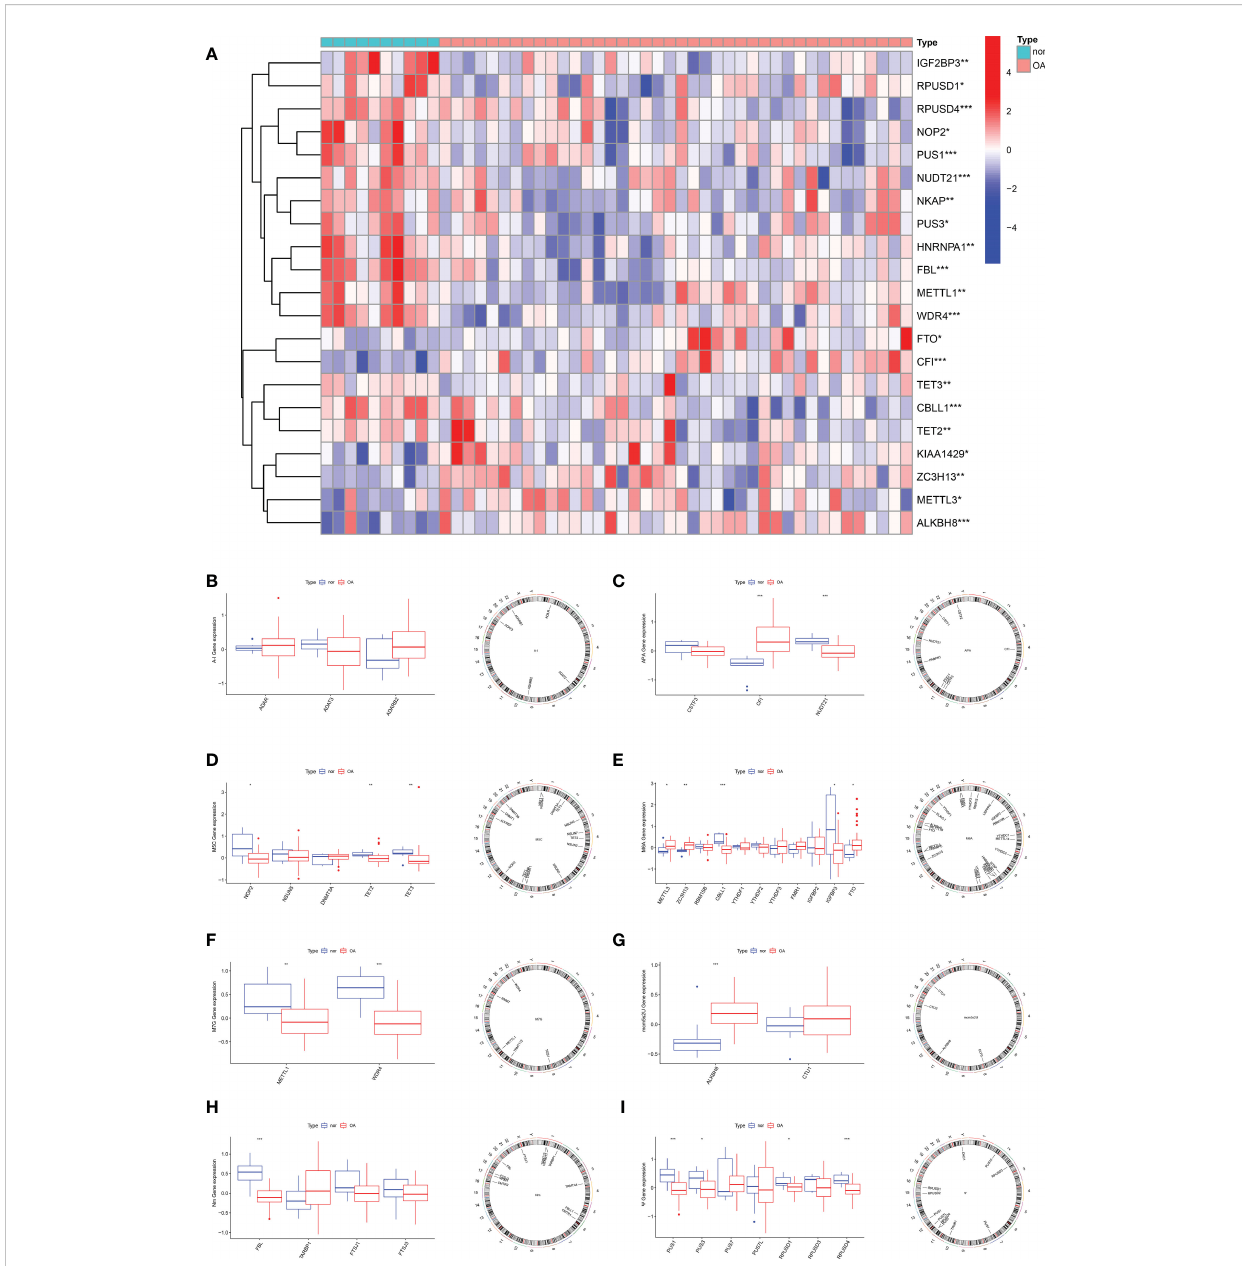
FIGURE 1 Expression characteristics and gene localization of RNA modi fi cation regulators. (A) Heat map showing the expression characteristics of RNA modi fi cation regulators in OA tissues and normal tissues. Red shows high expression levels while blue shows low expression levels; (B – I) box plot showing differences in the expression of A-I, APA, m5C, m6A,m7G, mcm5s2U, Nm and Y modi fi cation regulators in OA and normal tissues, and the position of their genes on the chromosome, respectively. (for all fi gures: * represents p <0.05, ** represents p <0.01 and *** represents p